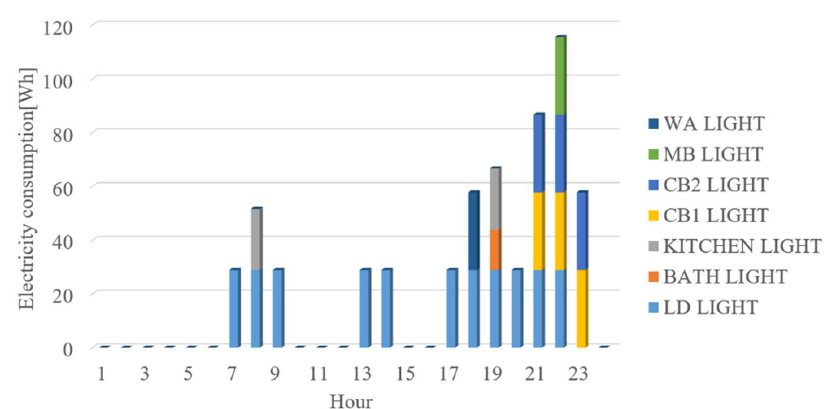
Figure 10. Hourly electricity consumption of lighting.